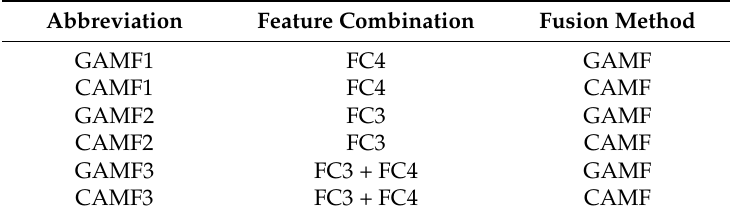
Table 5. Combination methods.